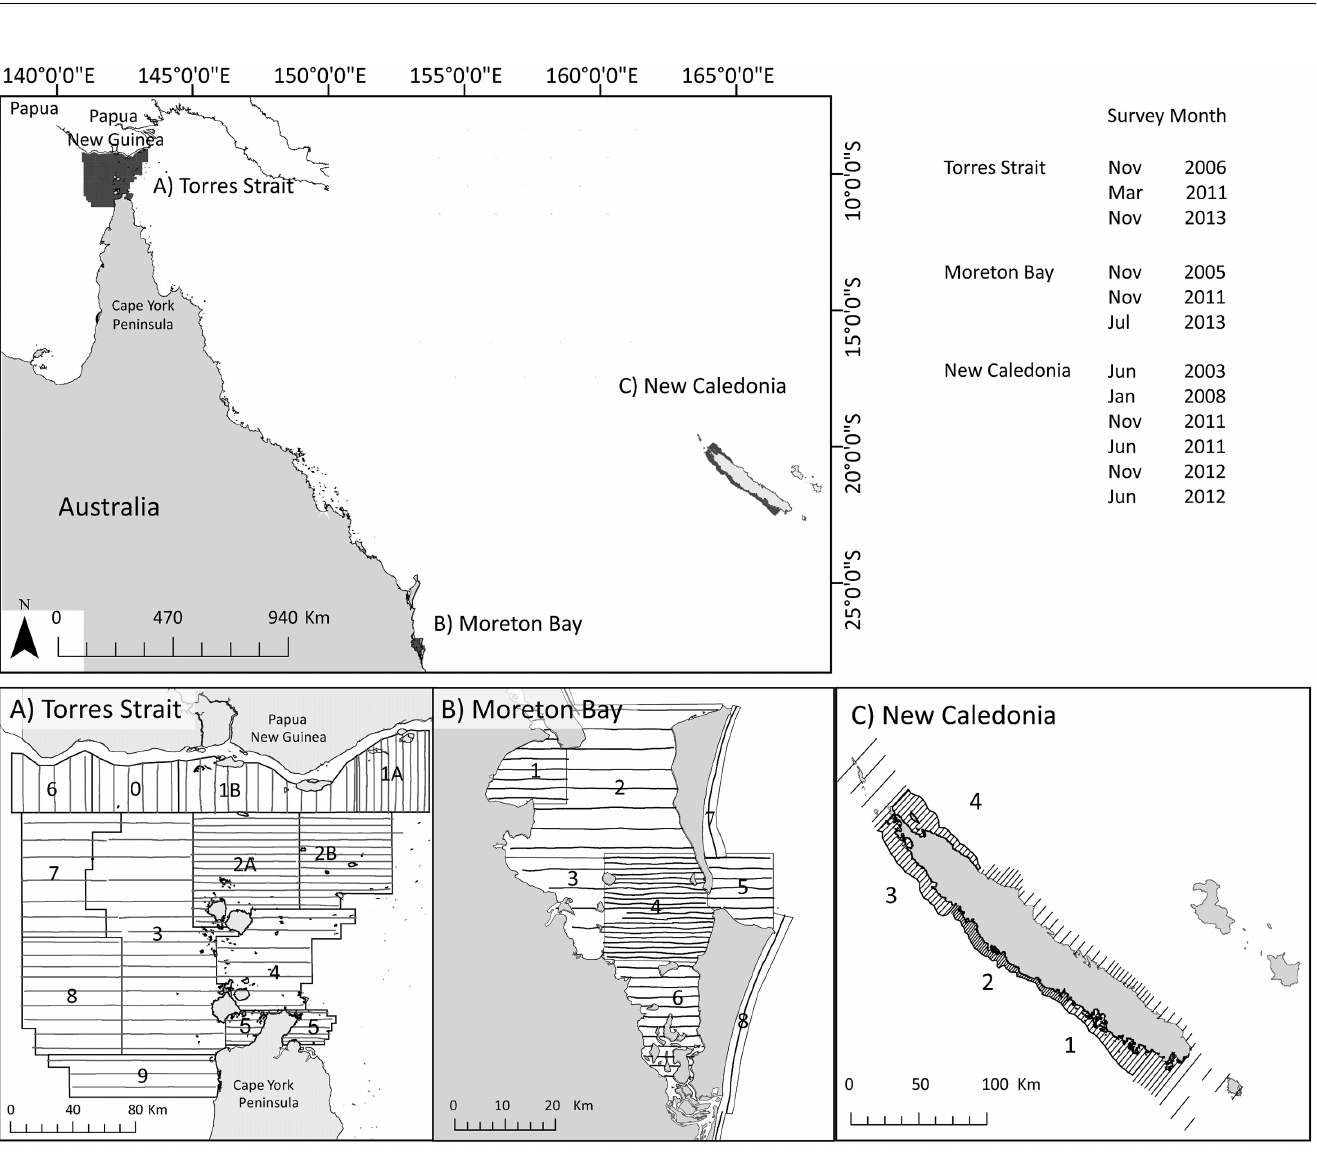
Fig 1. Maps showing dugong aerial survey blocks and transects in: A) Torres Strait, Australia, B) Moreton Bay, Australia and C) New Caledonia. Shaded areas and lines in the main map represent the survey area and transect lines. The month and year of the aerial surveys conducted at each location are shown in the top right